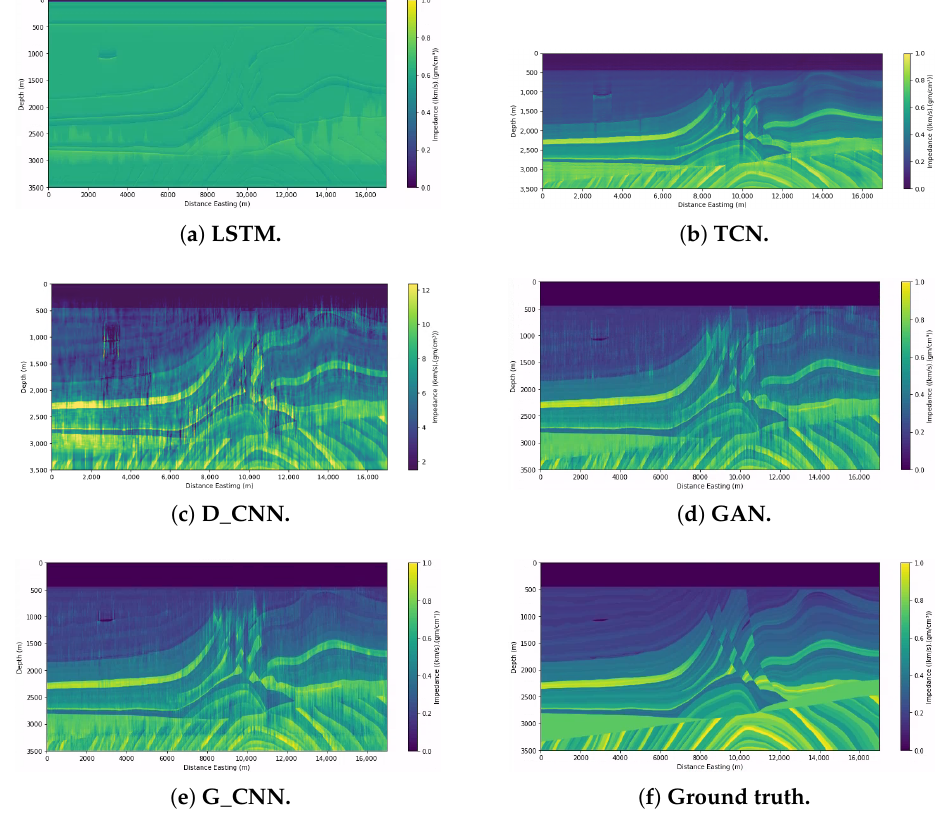
Figure 11. Prediction results for impedance sections for testing from the Marmousi2 dataset (without noisy